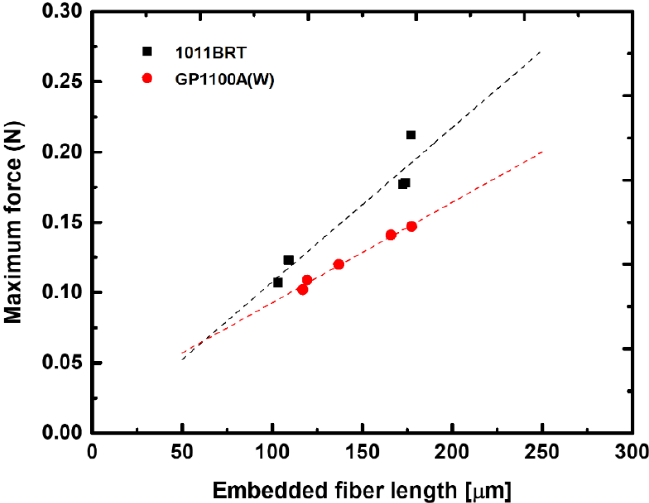
Figure 6. Results of the single fiber pullout test. Table 4. IFSS calculation result and standard deviation of the GF and PA6 interface.